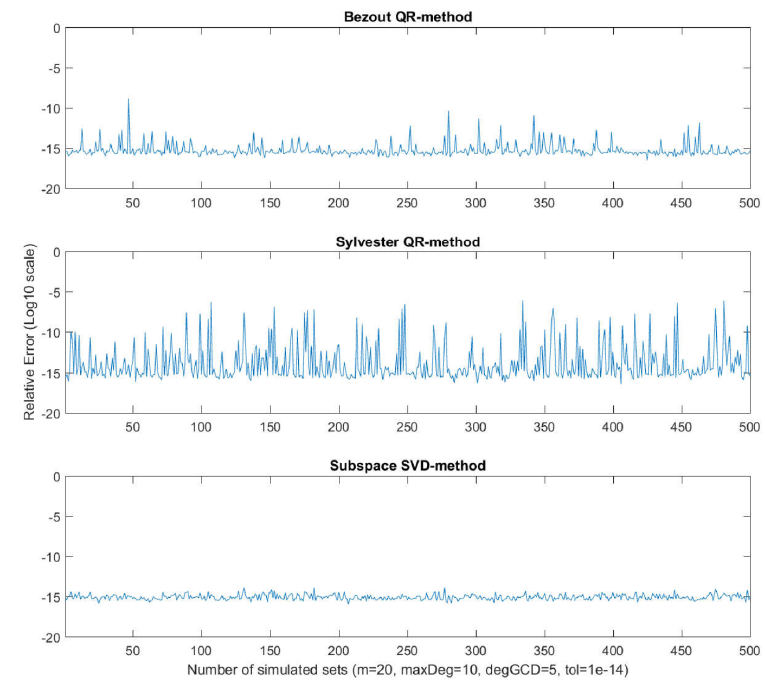
Figure 2: Numerical